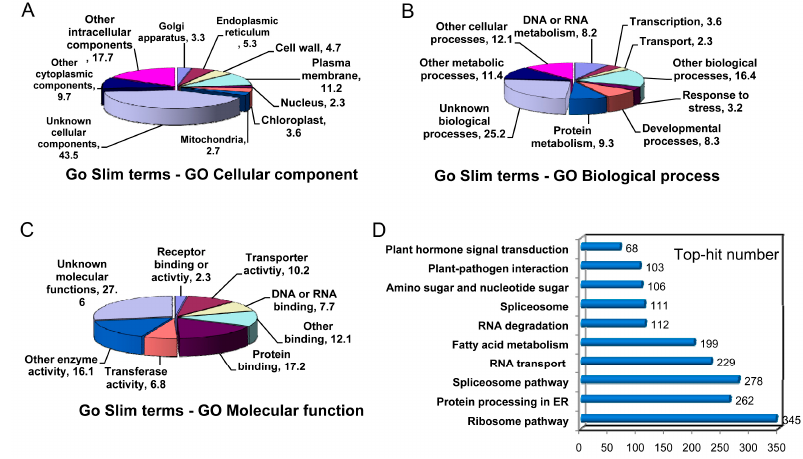
Figure 3. Functional categorizations of unigenes predicted by Gene Ontology (GO) terms and Kyoto Encyclopedia of Genes and Genomes (KEGG) pathway. Many unigenes were distributed into the cellular component ( A ); molecular function ( B ); and biological process ( C ) categories. Top 8–10 GO terms were demonstrated in each category; ( D ) The unigene number was shown in the top 10 KEGG pathways.